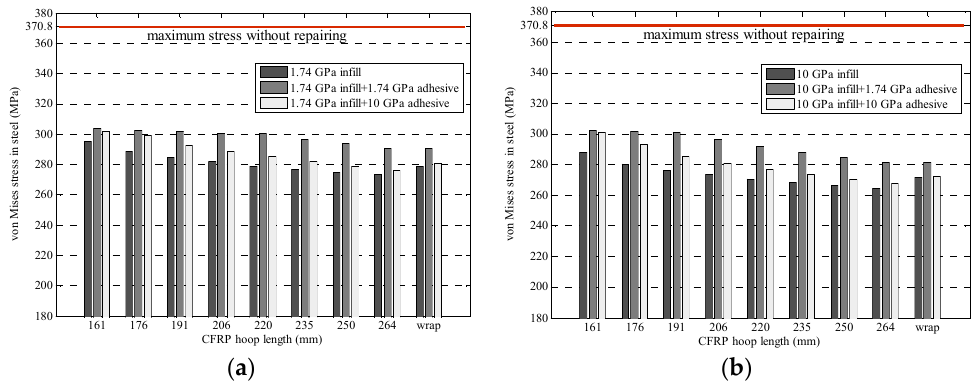
Figure 7. Effect of adhesive on von Mises stress in pipe with infill material of ( a ) 1.74 GPa epoxy and ( b ) 10 GPa inorganic composite.